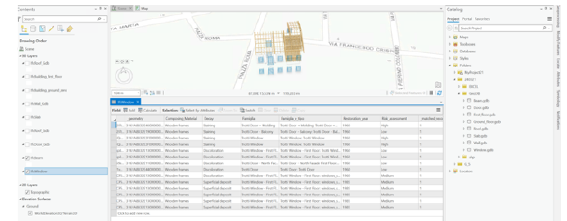
Figure 7 . A sample of the IFC-to-shapefile converted elements opened in the ArcGis Pro